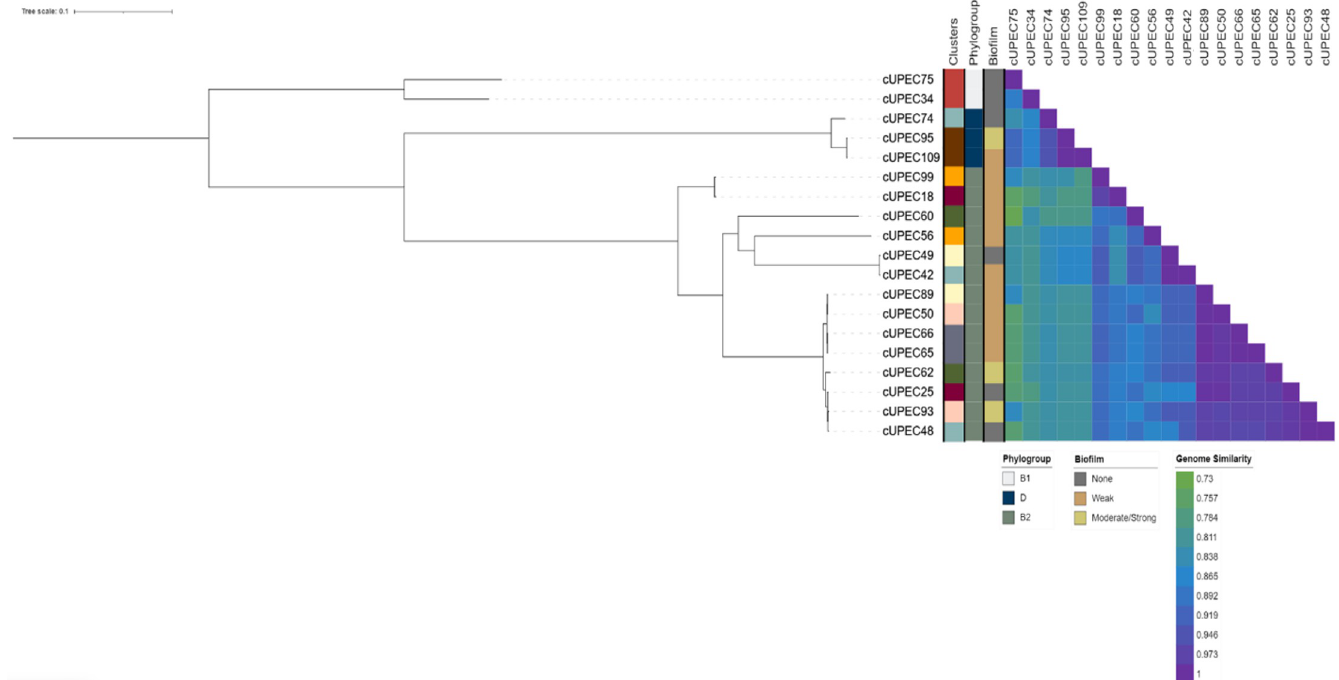
Fig 5. Maximum-likelihood tree of isolates from dogs that submitted two or more UPEC during the study period. Maximum likelihood phylogenetic tree of core SNP of 19 separate UPEC isolates. Metadata of the samples are present to the left of the tree including within-patient isolate clusters, isolate phylogroup, biofilm capacity and a heat map of between-isolate whole genome